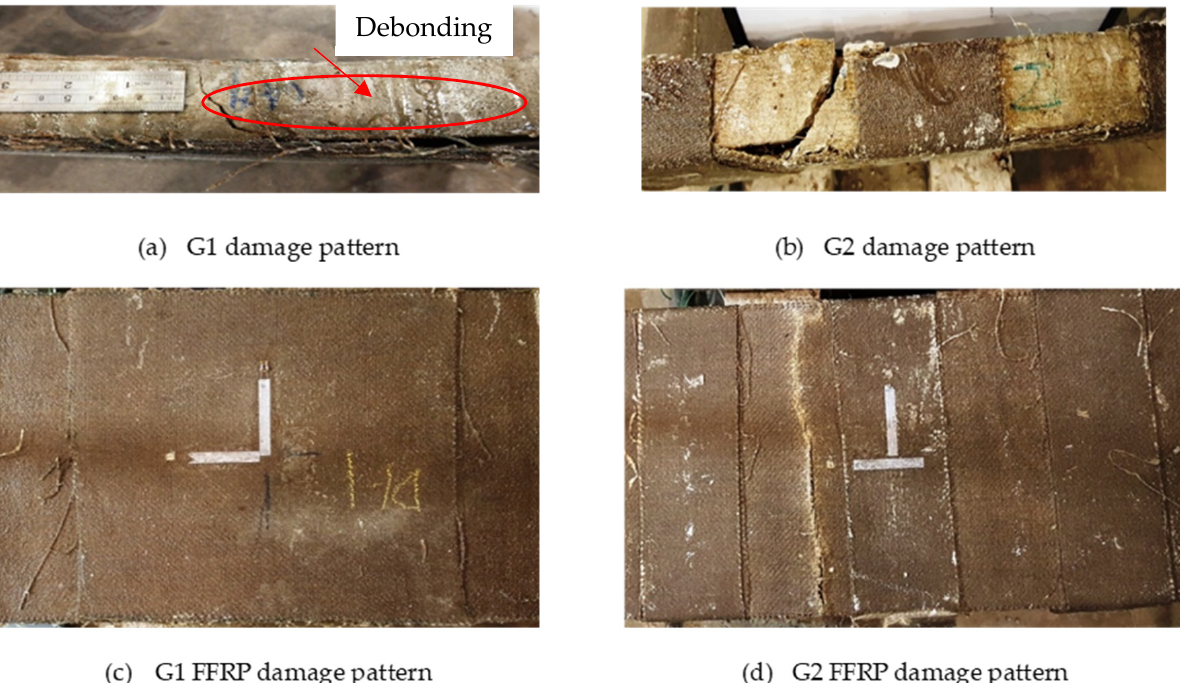
Figure 10. Damage patterns: ( a ) side view of G1 slab; ( b ) side view of G2 slab; ( c ) top view of G1 slab, and ( d ) top view of G2 slab.